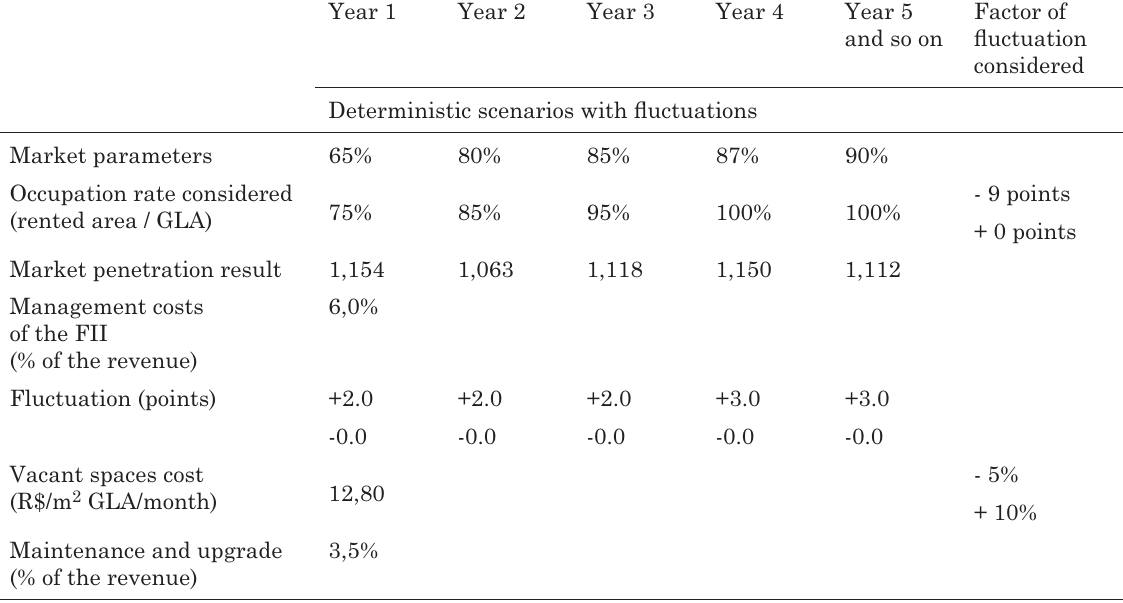
Table 2. Scenario for the operational cycle – occupation, costs, maintenance and